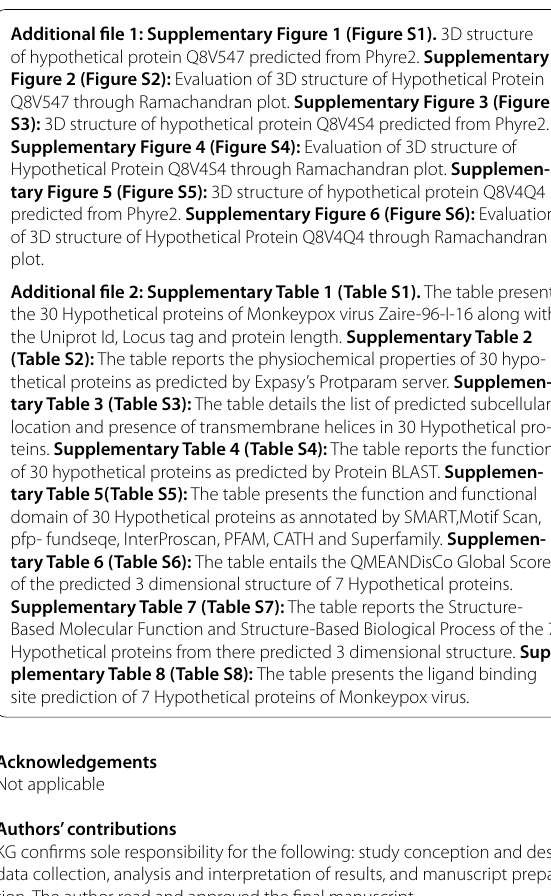
Figure 2 (Figure S2): Evaluation of 3D structure of Hypothetical Protein Q8V547 through Ramachandran plot. Supplementary Figure 3 (Figure S3): 3D structure of hypothetical protein Q8V4S4 predicted from Phyre2. Supplementary Figure 4 (Figure S4): Evaluation of 3D structure of Hypothetical Protein Q8V4S4 through Ramachandran plot. Supplemen- tary Figure 5 (Figure S5): 3D structure of hypothetical protein Q8V4Q4 predicted from Phyre2. Supplementary Figure 6 (Figure S6): Evaluation of 3D structure of Hypothetical Protein Q8V4Q4 through Ramachandran plot. Additional file 2: Supplementary Table 1 (Table S1). The table presents the 30 Hypothetical proteins of Monkeypox virus Zaire-96-I-16 along with the Uniprot Id, Locus tag and protein length. Supplementary Table 2 (Table S2): The table reports the physiochemical properties of 30 hypo- thetical proteins as predicted by Expasy’s Protparam server. Supplemen- tary Table 3 (Table S3): The table details the list of predicted subcellular location and presence of transmembrane helices in 30 Hypothetical pro- teins. Supplementary Table 4 (Table S4): The table reports the function